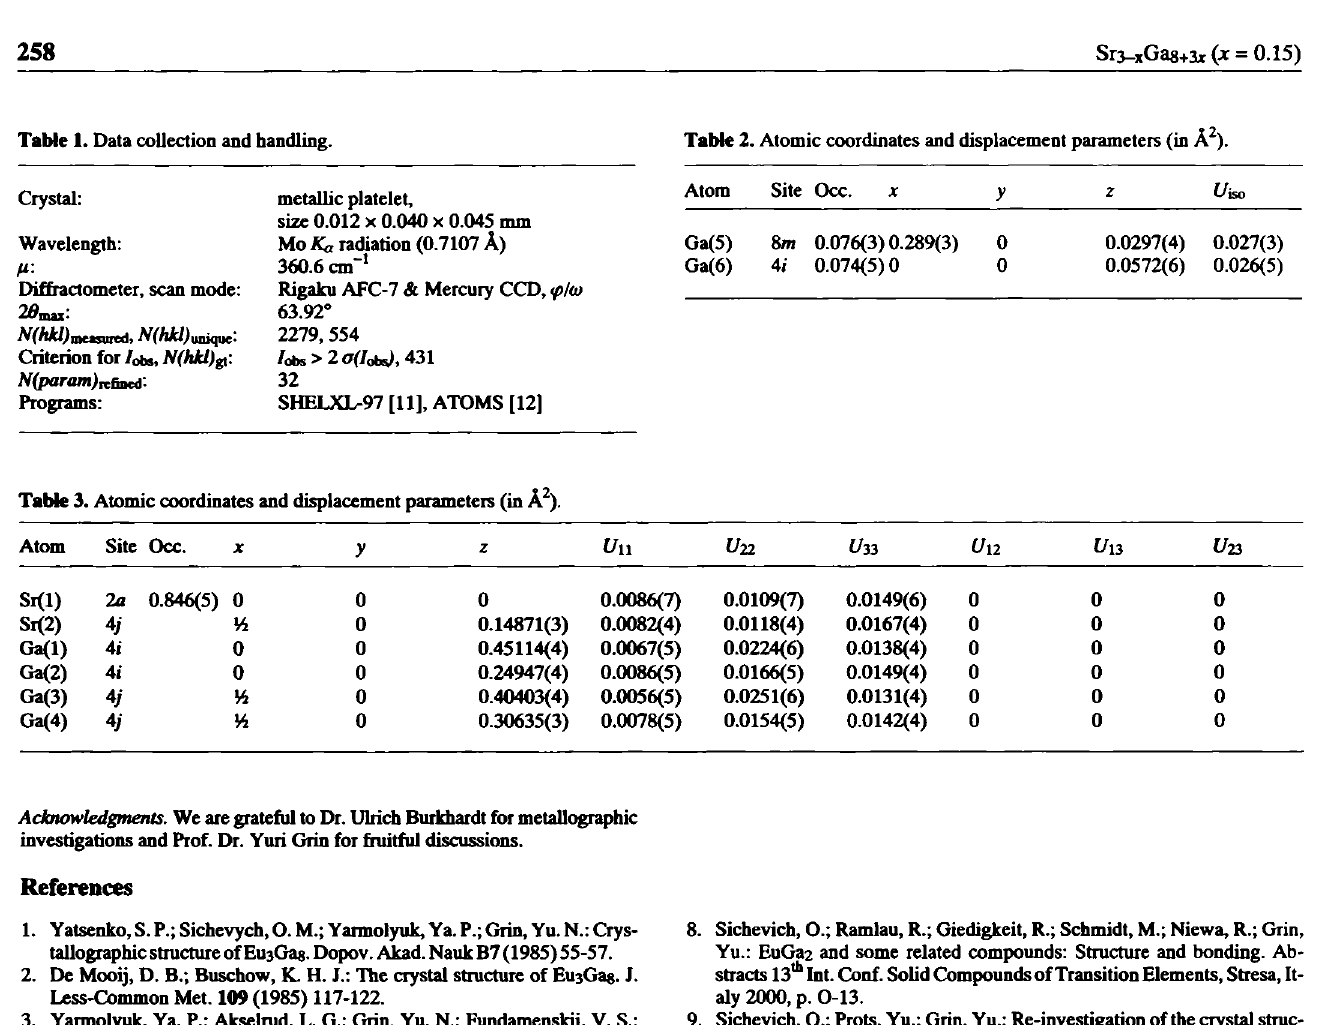
Table 3. Atomic coordinates and displacement parameters (in A 2